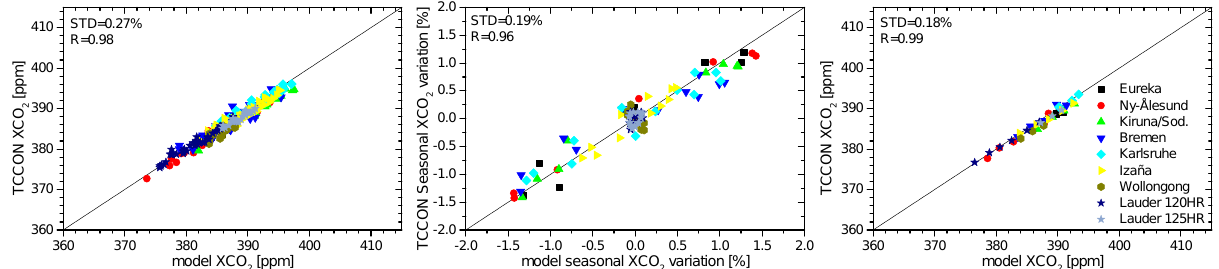
Figure 5. Correlation of TCCON vs. XCO 2 model for the time period 2005–2012. Left: monthly means, middle: detrended seasonal cycles, right: de-seasonalised yearly means. Added is the one-to-one correlation (black line). At Lauder, two TCCON instruments have been used (Bruker 120HR / 125HR).